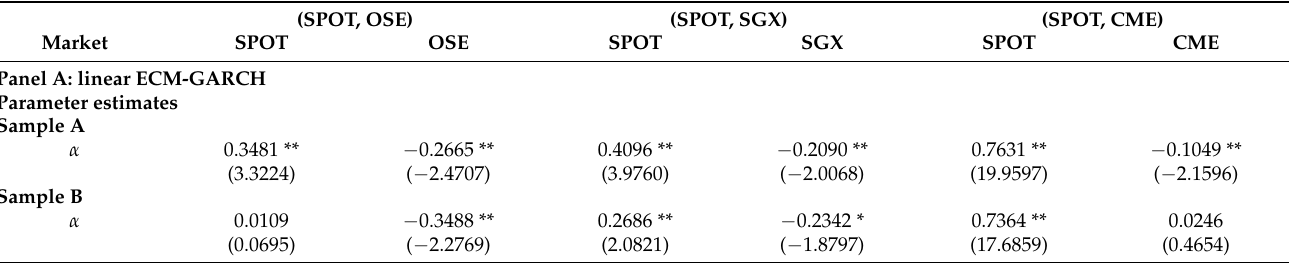
Table 3. Estimation results: Spot–futures price